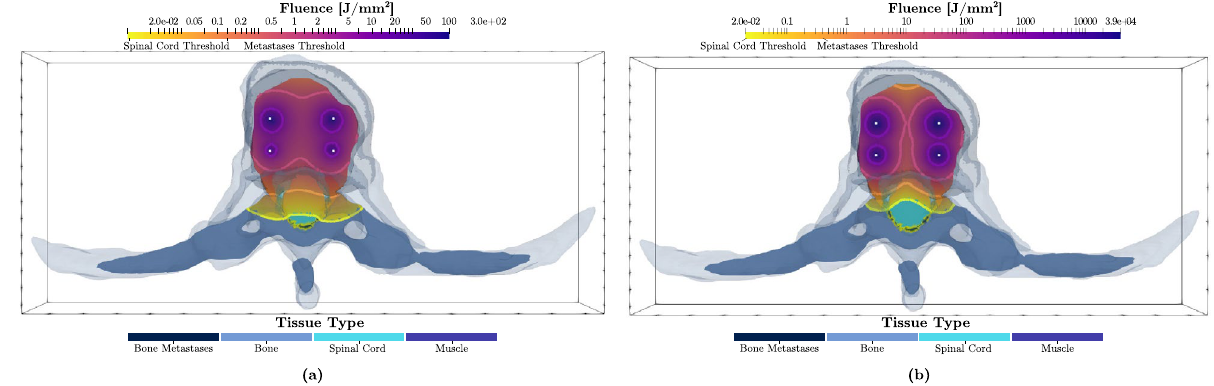
Figure 4. Optimized treatment plans for wavelengths of ( a ) 690 nm and ( b ) 565 nm using a 4-source configuration (4 cut-end fibres with NA = 0.22 and 200 µ m radius positioned at the center of the metastatic lesion). The resulting iso-fluence contours are overlaid on the 3D model, demonstrating the achievement of − 2 the minimum necrotic threshold within the metastatic region (0.4 J mm ) as per the colour map shown. The total energy at the 690 nm wavelength ( E total = 1247.6 J) was distributed across the 4 cut-end fibres [ordered horizontally from top left to bottom right) as follows: E 1 = 439.6 J, E 2 = 487.6 J, E 3 = 189.6 J, E 4 = 130.8 J. 3 3 At 565 nm, the total energy E total = 167.3 × 10 J, distributed across the 4 cut-end fibres as: E 1 = 64.6 × 10 J, E